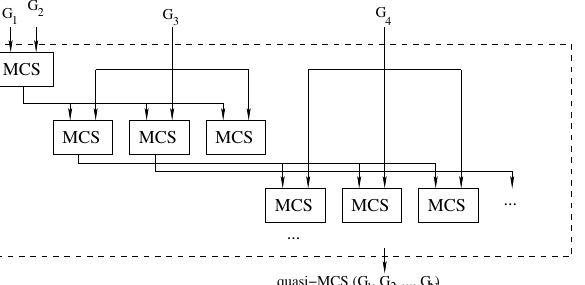
Figure 7. The improved waterfall approach: Each call to the MCS function computes multiple intermediate solutions. For each solution, we run a new sequence of MCS problems. A threshold heuristically limits the expansion